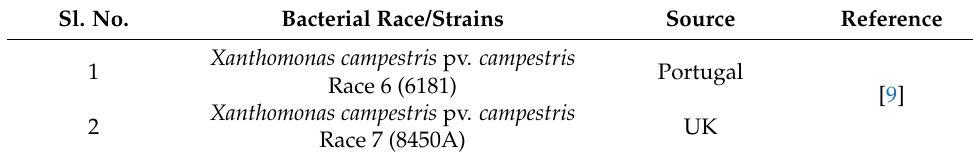
Table 3. Xanthomonas campestris pv. campestris ( Xcc ) races used in this study. Sl.